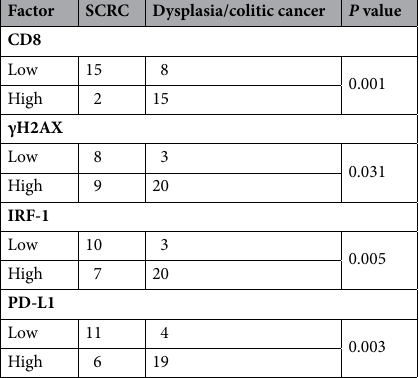
Table 4. Differences in the expression of immune-related factors between sporadic colorectal cancer (SCRC) and dysplasia/colitic